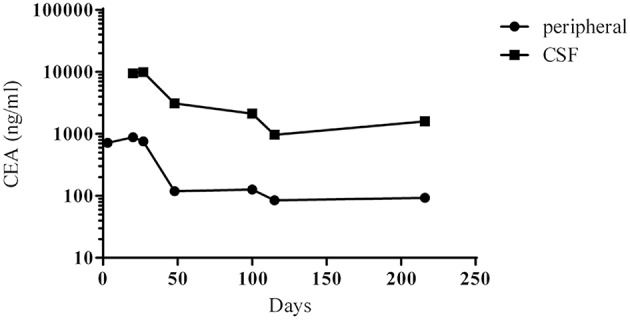
Changes in the concentrations of CEA in peripheral blood and CSF between day 1 (the initial admission) and day 216. Therapy with afatinib was commenced on day 27.